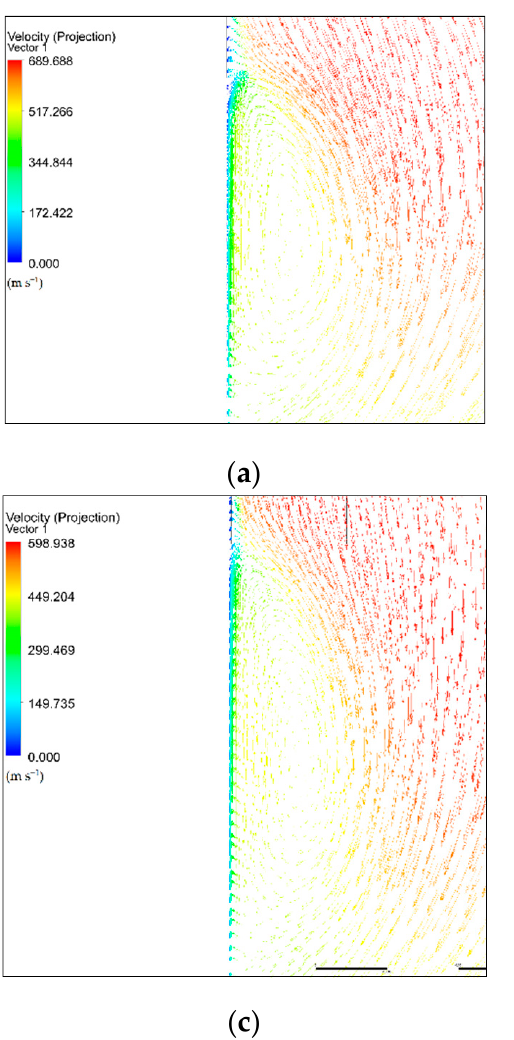
Figure 17. Vector velocity distribution obtained for SVT with ( a ) air ; ( b ) He ; and ( c ) CO 2 .